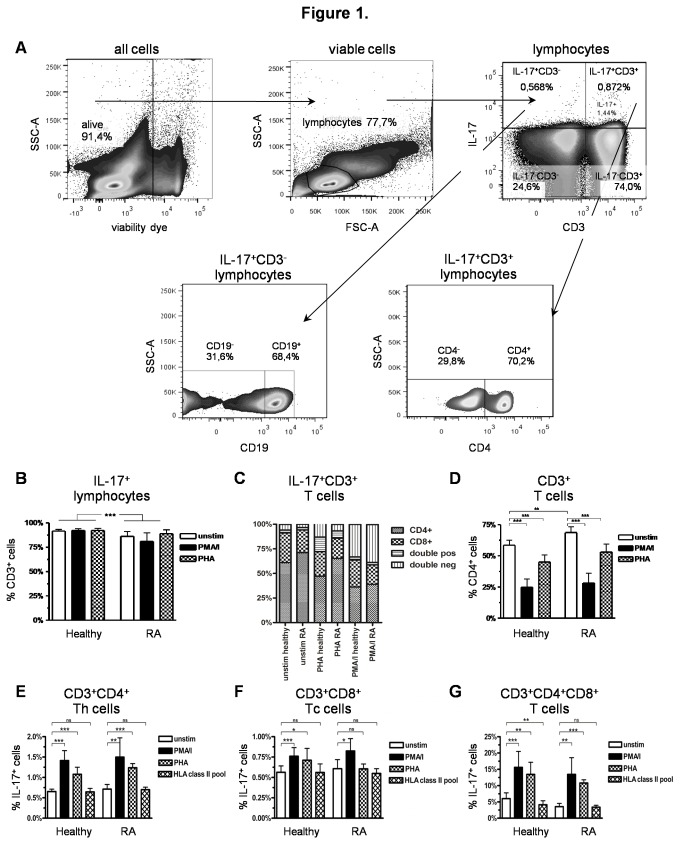
Gating strategy and IL-17+ T cells in RA patients and healthy controls.A) Exemplary gating strategy shown on representative pseudo-colour dot-plots of unstimulated PBMC of a RA patient. Dead cells were excluded using EMA-viability dye. Lymphocytes were gated (FSC vs. SSC), followed by the subgating of CD3+ and IL-17+ cells. IL-17+CD3+ T cells and IL-17+CD3- non-T cells were further specified. Frequencies in each subgate are expressed as percentage of their parent population; B-D) Comparative analysis of CD3+ lymphocytes in PBMC stimulated with PMA/i, PHA or incubated in RPMI-1640 without stimulation for 20 h in RA patients and healthy controls; B) Percentage of CD3+ T cells within the IL-17+ lymphocytes; C) Percentage of CD4+ and CD8+ cells within the IL-17+CD3+ T cell population, D) Percentage of CD4+ cells within CD3+ T cells; E-F) Comparative analysis of IL-17 expression in different T cell populations stimulated with PMA/i, PHA, a pool of 23 peptides of MHC-class II-restricted T cell epitopes or incubated in RPMI-1640 without stimulation for 20 h; E) Percentage of IL-17+ cells within CD3+CD4+ Th cells; F) Percentage of IL-17+ cells within CD3+CD8+ Tc cells; G) Percentage of IL-17+ cells within CD3+CD4+CD8+ double positive T cells.Data from healthy controls (n = 20) and RA patients (n = 20). *p < 0.05; **p < 0.01, ***p < 0.001,ns = not significant, column represents the mean and bars indicate 95% CI.